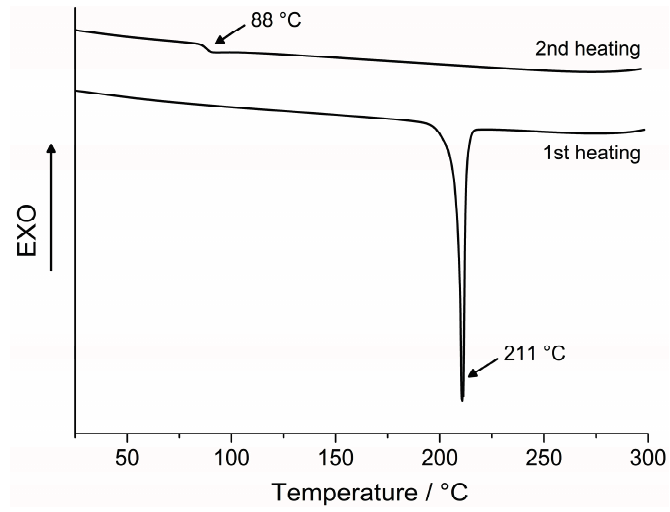
Figure 2. First and second heating DSC curves of 2 (heating rate 10 °C · min − 1 , N 2 atmosphere).